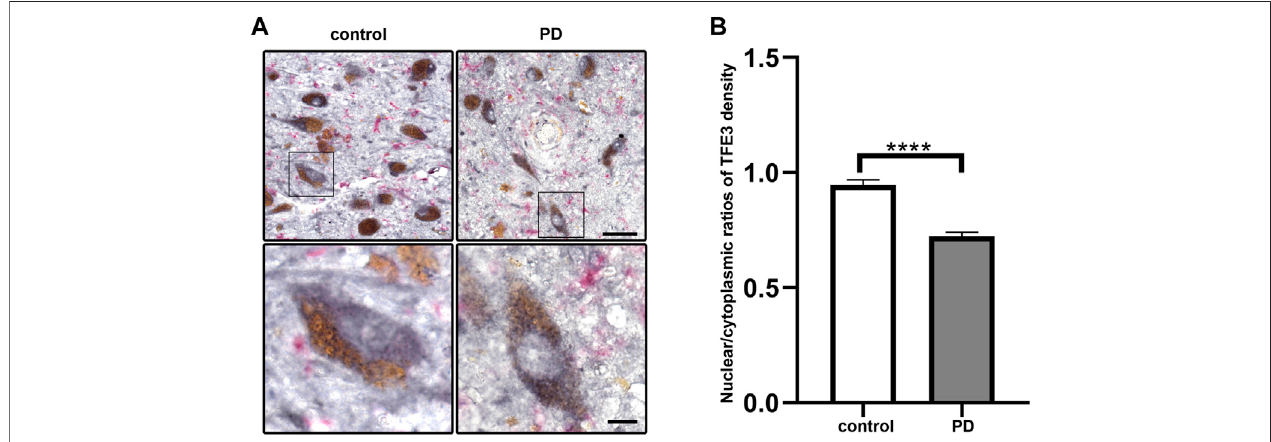
FIGURE 1 | Nuclear TFE3 expression is reduced in the SN dopaminergic neurons of PD patients. (A) Sections of human SN obtained from PD or control subjects were immunostained using a TFE3 antibody visualized by DAB staining (gray-black) and a Iba1 antibody visualized by ImmPACT Vector Red staining (magenta). Scale bars:upperpanel:50 μ m;lowerpanel:10 μ m. (B) Quanti fi cationofthenucleartocytoplasmicratiosofTFE3inhumanSNdopaminergicneurons.n (cid:1) 436dopaminergic neurons from 5 PD patients and 898 dopaminergic neurons from fi ve controls, respectively. Data are expressed as the mean ± SEM. **** p < 0.0001, two-tailed Student ’ s t